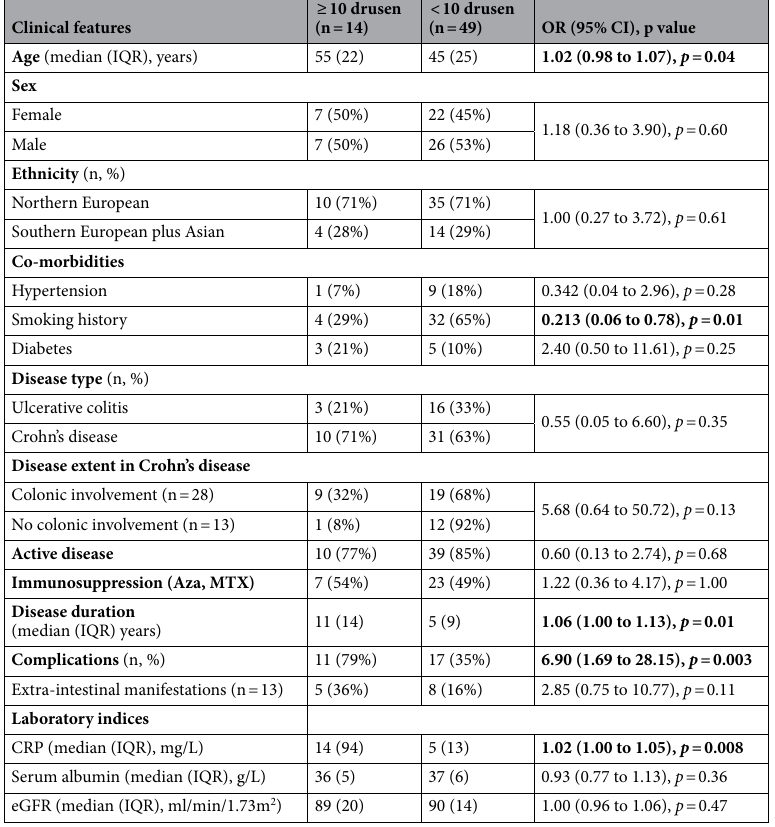
Table 3. Central drusen counts ≥ 10 and clinical associations in all participants with IBD. Aza, MTX – azathioprine, methotrexate. Significant values are in